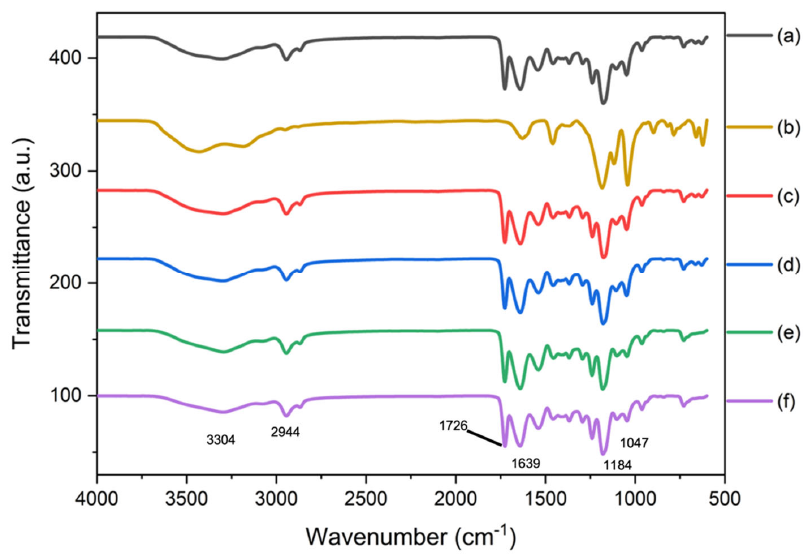
Figure 4. FTIR spectrum of (a) PG, (b) SCX4, (c) PGC ‐ 3, (d) PGC ‐ 5, (e) PGC ‐ 10, and (f) PGC ‐ 15.